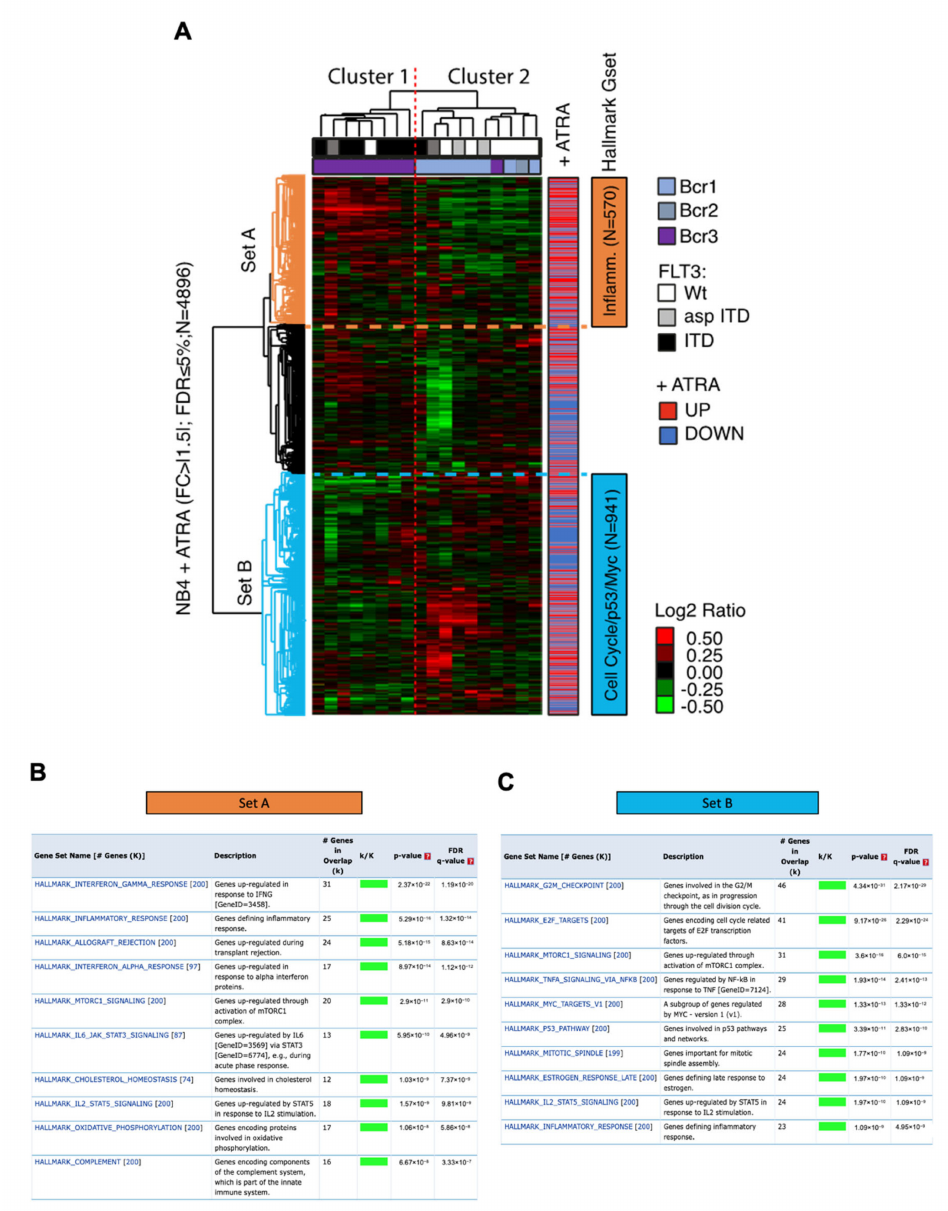
Figure 5. GeneexpressionmetanalysisofexternaldatasetsusingtheATRA-regulatedgenes. ( A )Hierarchical clustering of ATRA-regulated genes (Log2 ratios of expression: ATRA vs. vehicle- treated cells) measured also in Marasca and coworkers dataset representing 18 APL cases (GEO Database accession #: GSE:2550). Two distinct clusters were identified, i.e. Cluster 1 and Cluster 2, which show a large fraction of up- ( n = 570, Set A) or downregulated genes ( n = 941, Set B), respectively, in APL cases carrying FLT3 -ITD mutations. The original trend of regulation of ATRA-regulated genes is also showed in the colored bar ( + ATRA). In blue, ATRA downregulated genes; in red, ATRA upregulated genes. The genetic characteristics of APL cases are also reported with color codes as per the legend. ( B ) and ( C ) reports the analysis of the overlap of genes, i.e. Set A ( n = 570) and Set B ( n = 941) with the “Hallmark” gene sets present in the Molecular Signature Database (MSigDB). The top-10 Hallmark gene sets in terms of their overlapping significance (FDR < 5%) are reported. Set A is mostly represented by Hallmark gene sets involved in inflammatory response, while Set B is mostly represented by gene sets involved in cell cycle control, p53 and MYC